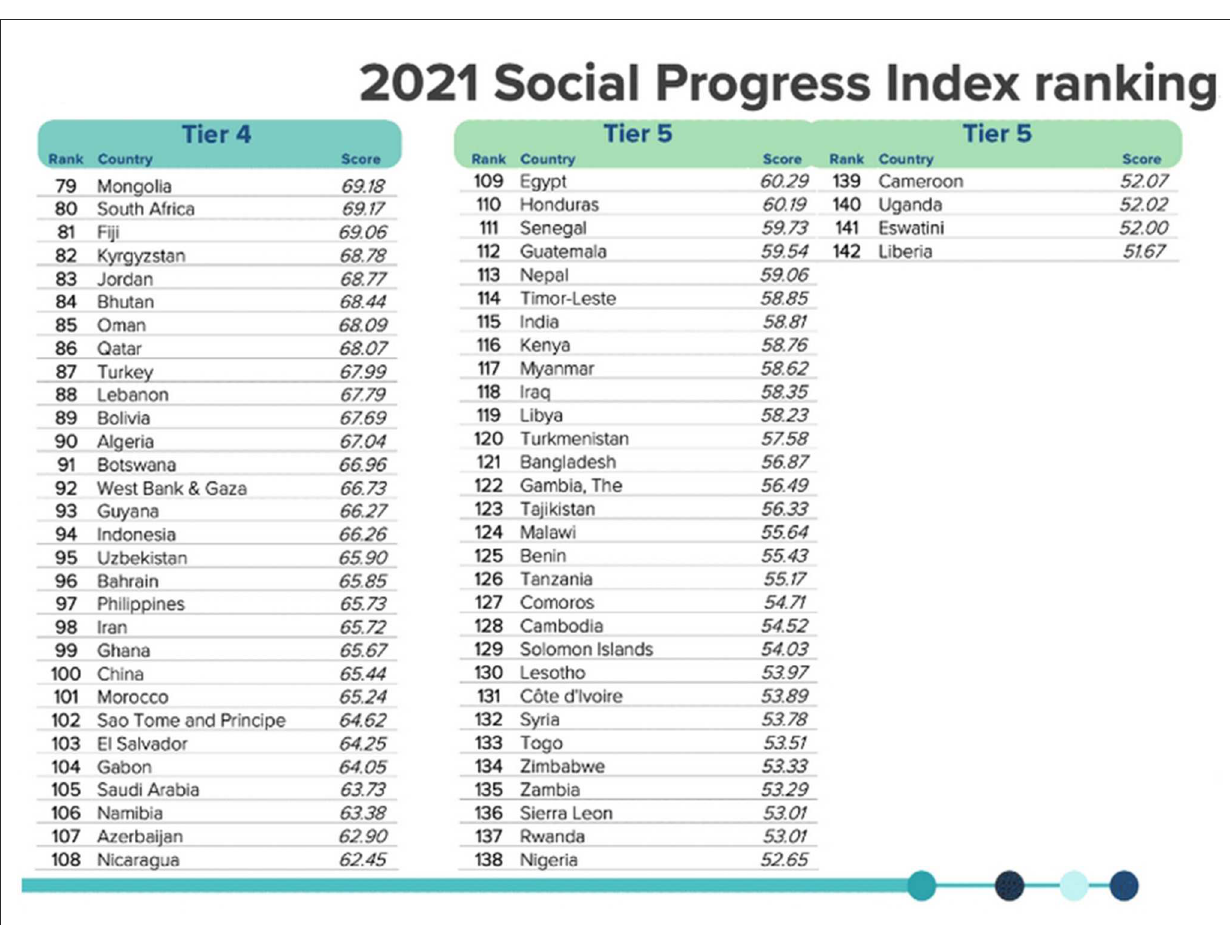
FIGURE10 The 2021 Social Progress Index Rankings (SPI) places China in 100th position out of 168 countries. Available online at: https://www.socialprogress. org/?code=CHN (accessed February 06, 2023).